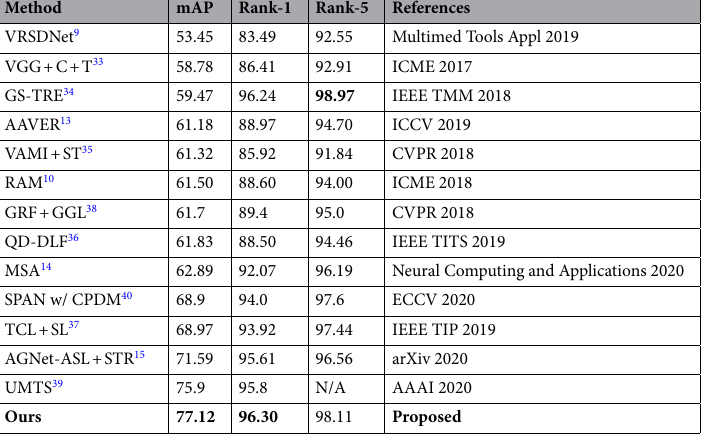
Table 5. The mAP, Rank-1 and Rank-5 on VeRi-776 dataset (in %). Bold indicate the best results for the corresponding metrics. N/A indicates that no data is provided.